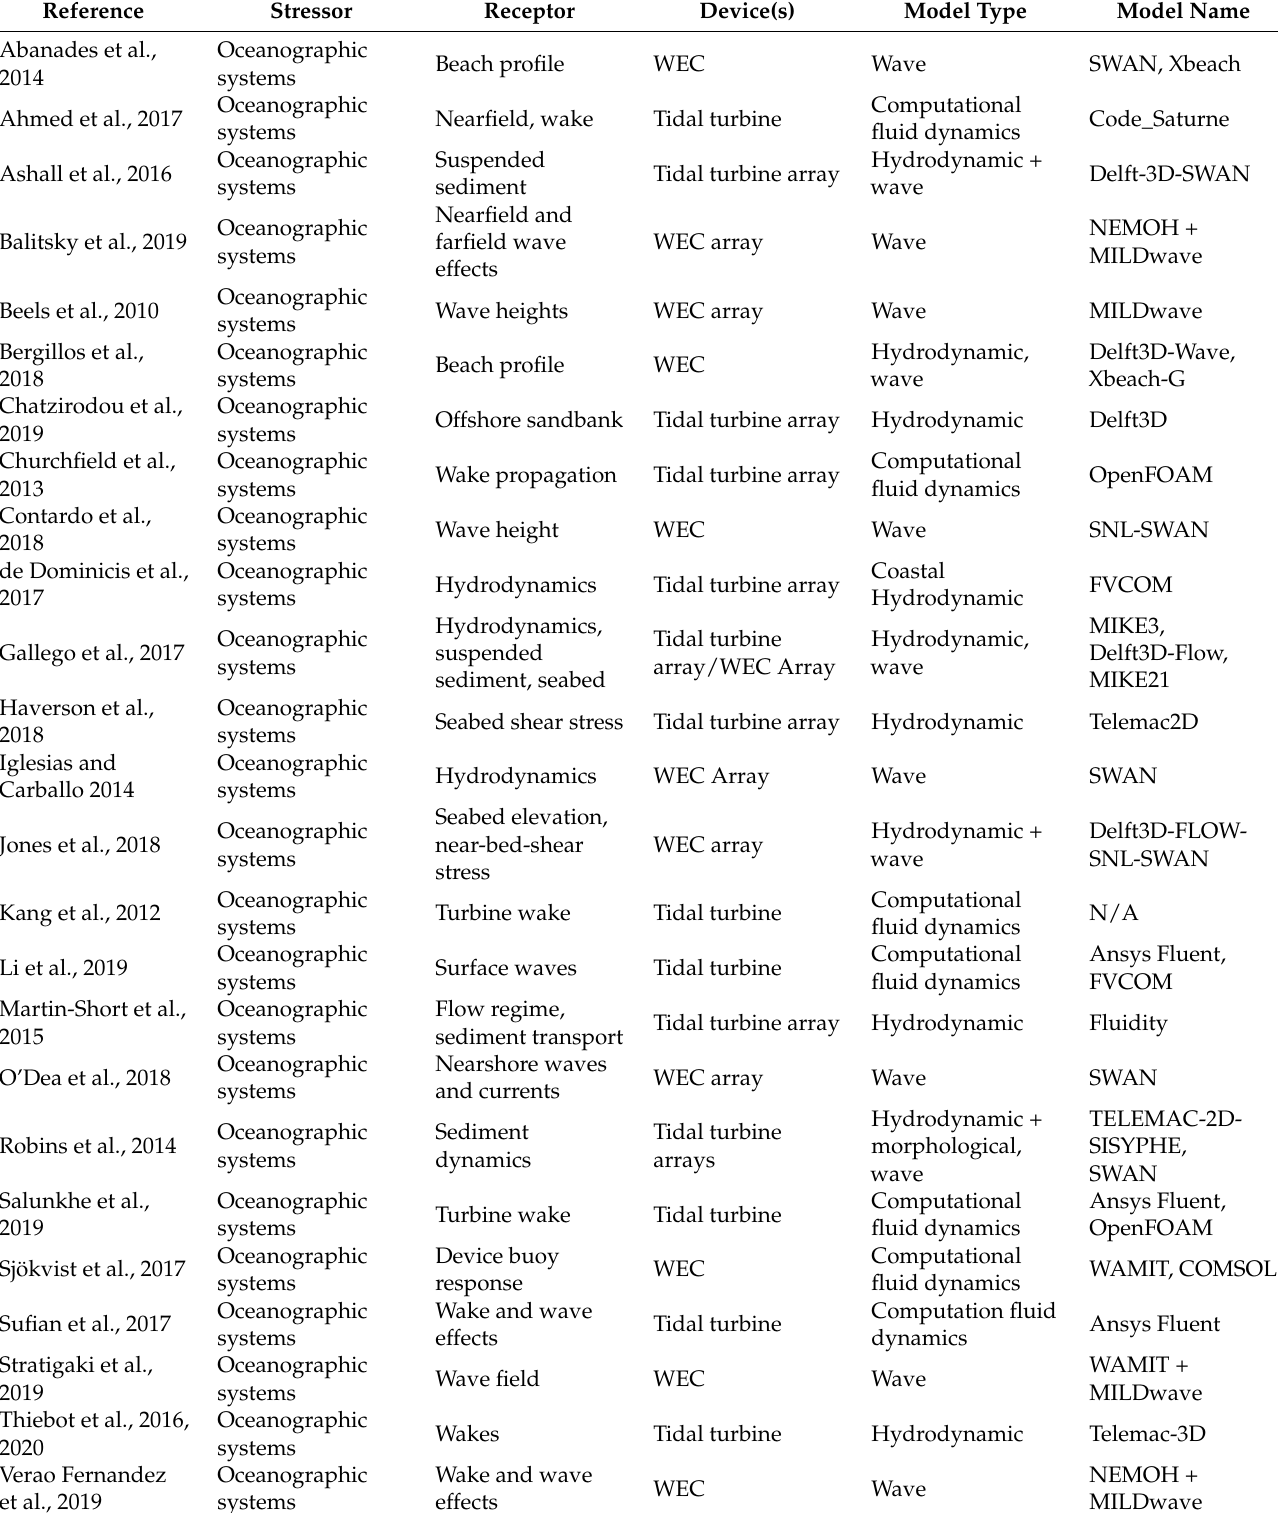
Table A2. Summary of reviewed models that addressed marine energy devices. A “+” indicates the coupling of models, if not already indicated by the model name. ME = marine energy, WEC = wave energy